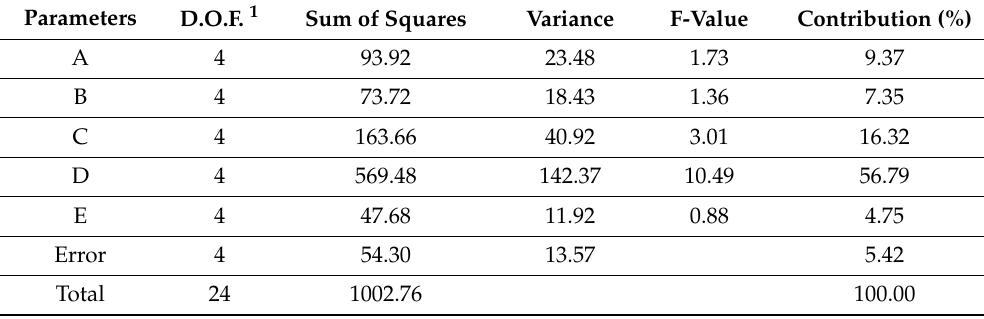
Table 10. ANOVA of air outlet exergy.